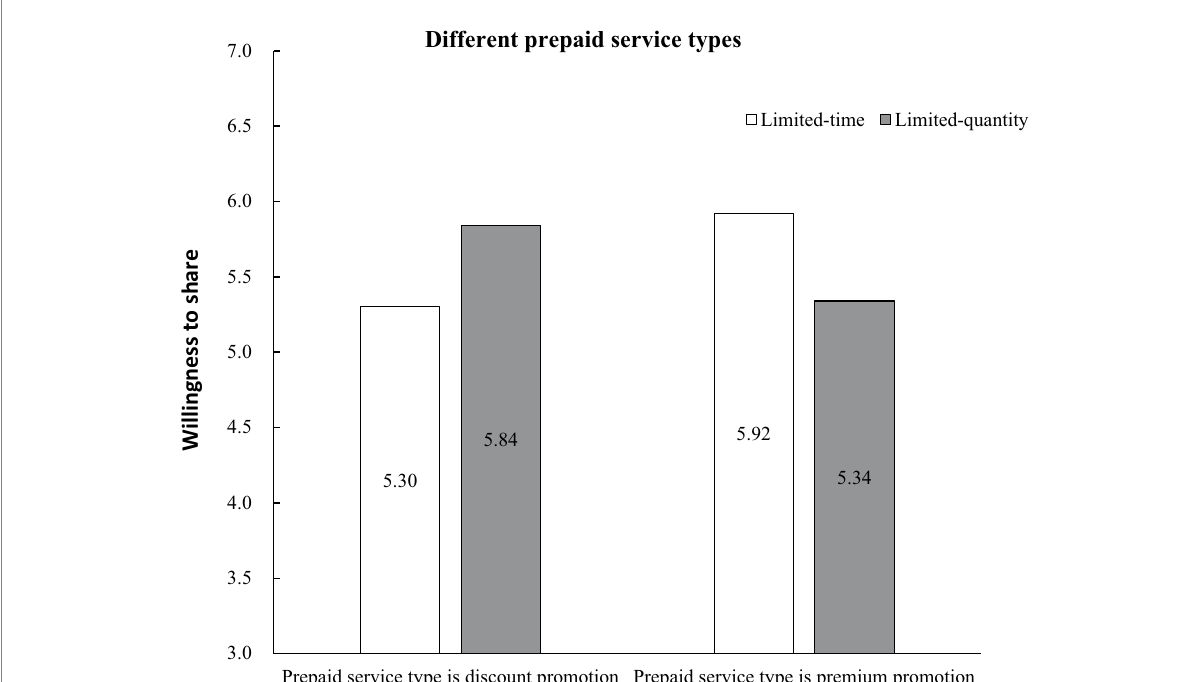
FIGURE 1 Influence of purchase restrictions on consumers’ willingness to share under different prepaid service